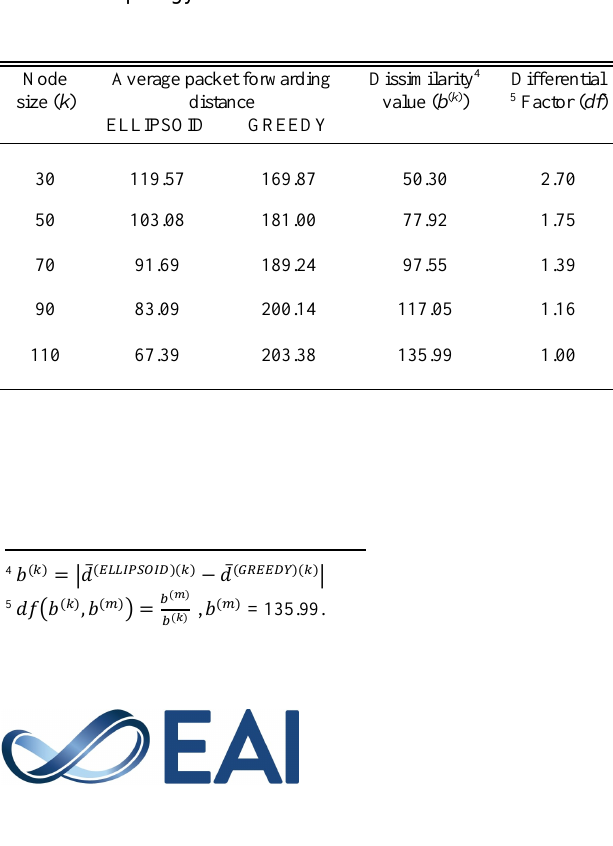
Table 2. Topology character of the VANET environment